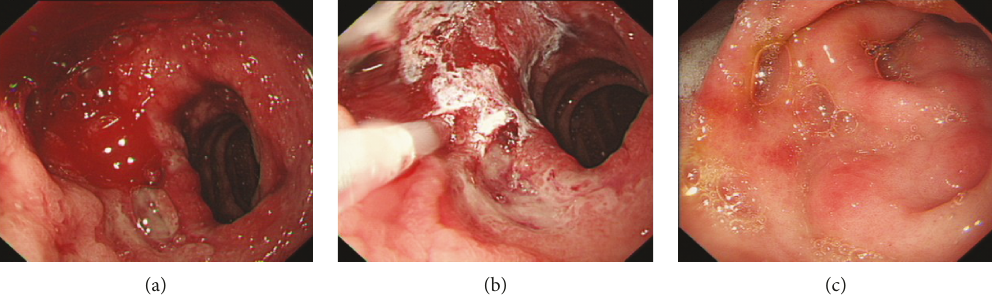
Figure 1: A male (58 years old) duodenal DL patient received cyanoacrylate injection during upper endoscopy. (a) An active bleeding was observed on the descending part of the duodenum. (b) Cyanoacrylate injection. (c) One month after endotherapy.